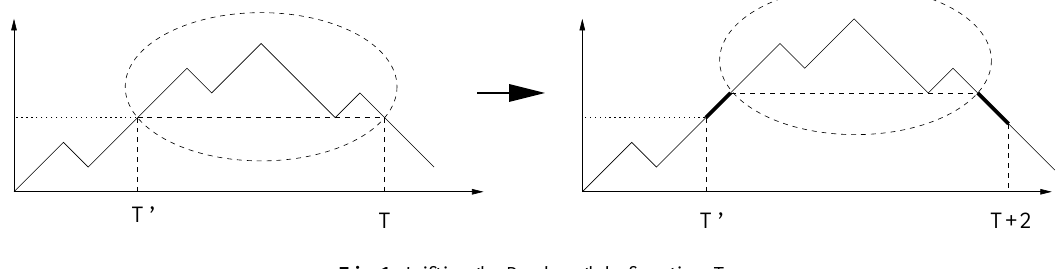
Fig. 1: Lifting the Dyck path before time T